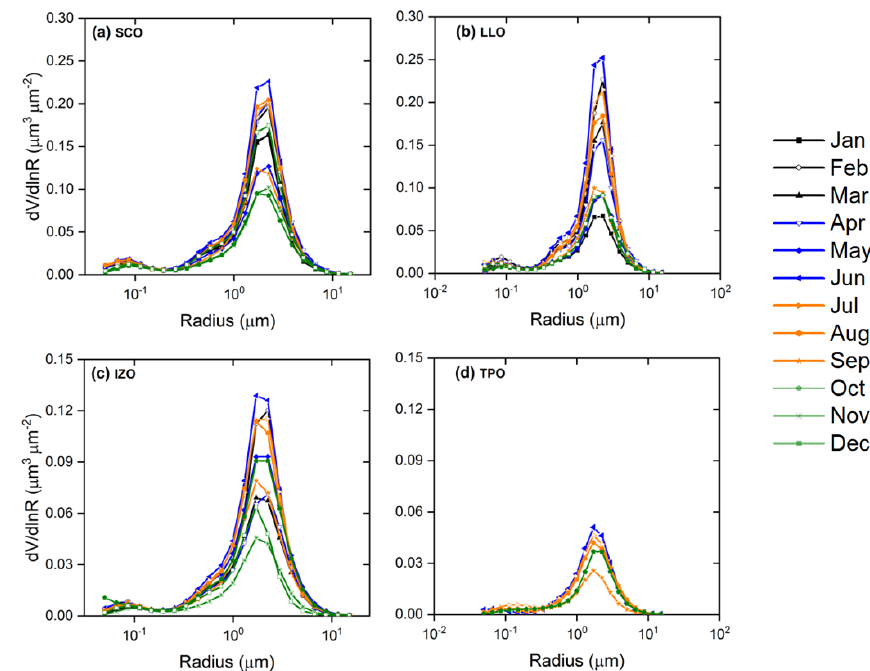
Figure 7. Monthly mean aerosol particle size distributions at (a) SCO, (b) LLO, (c) IZO and (d) TPO under dust-laden